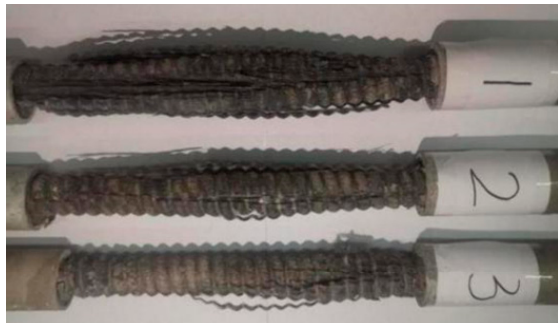
Figure 5. drawing failure of GFRP bars. Figure 5. Drawing failure of GFRP